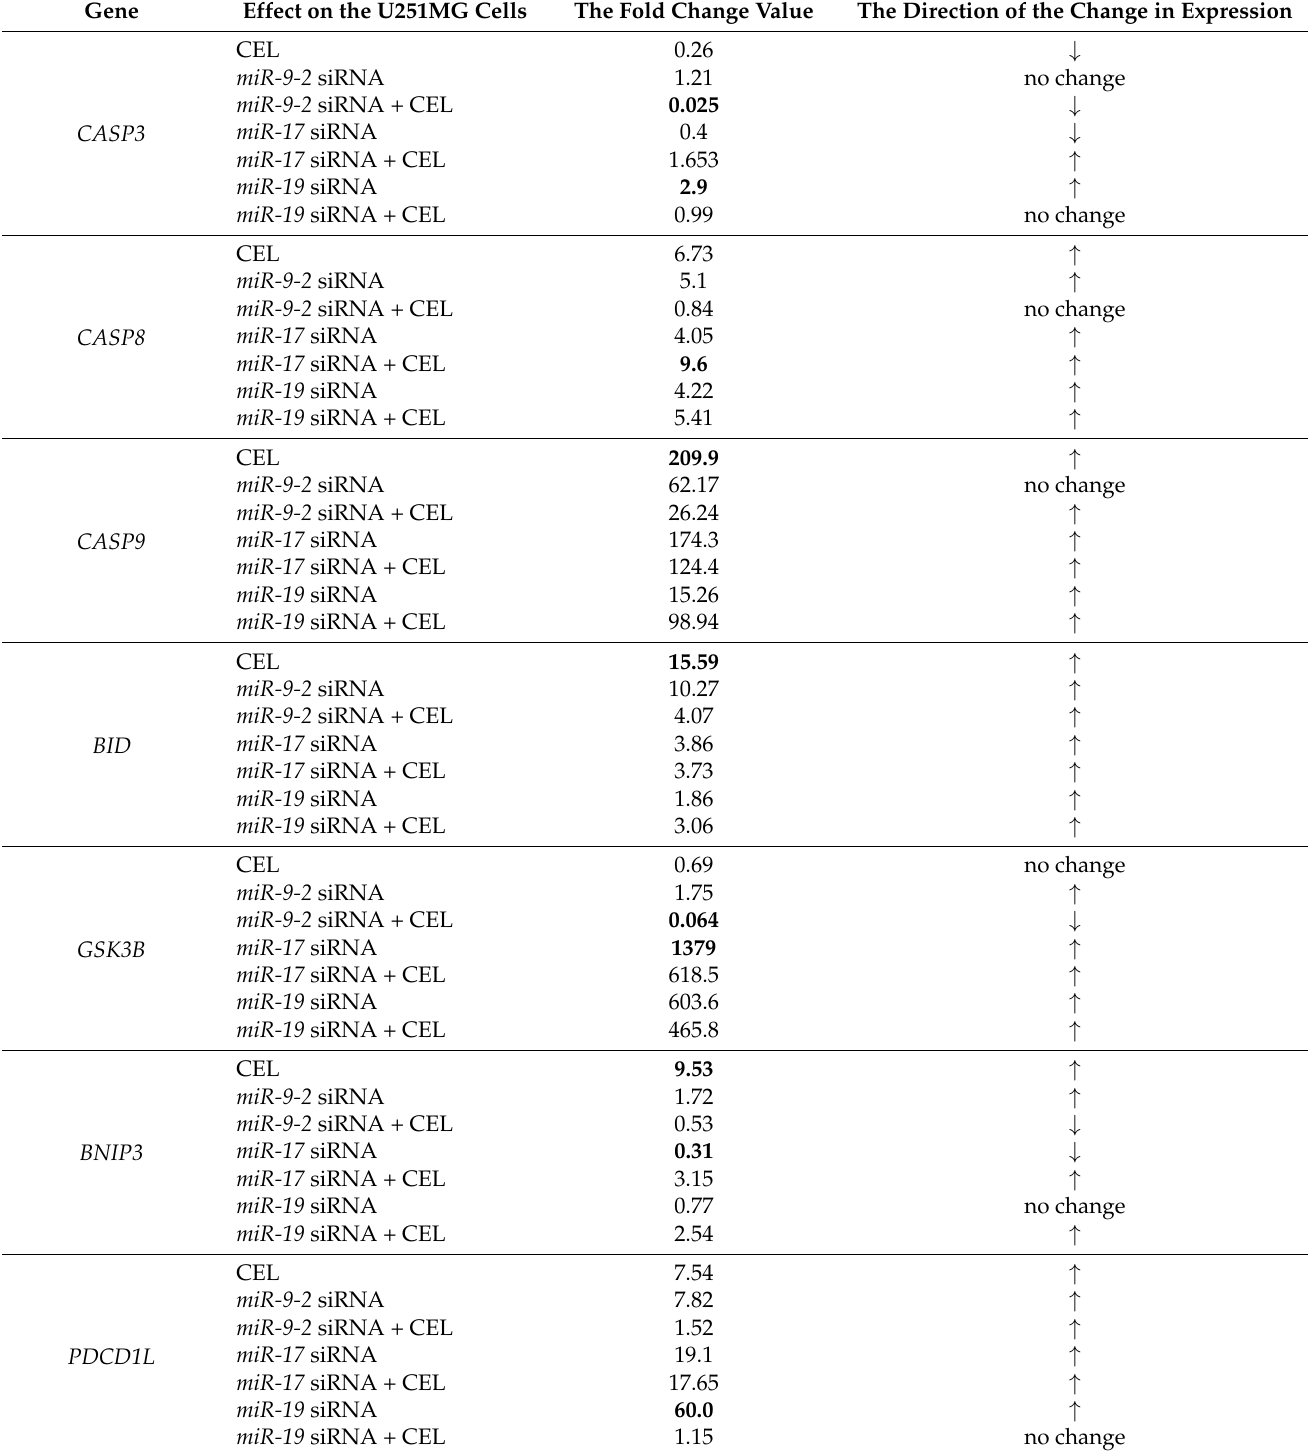
Table 5. Mean fold change value (relative to the control cells) and the direction of the change in the expression of the apoptosis-related genes in the U251MG